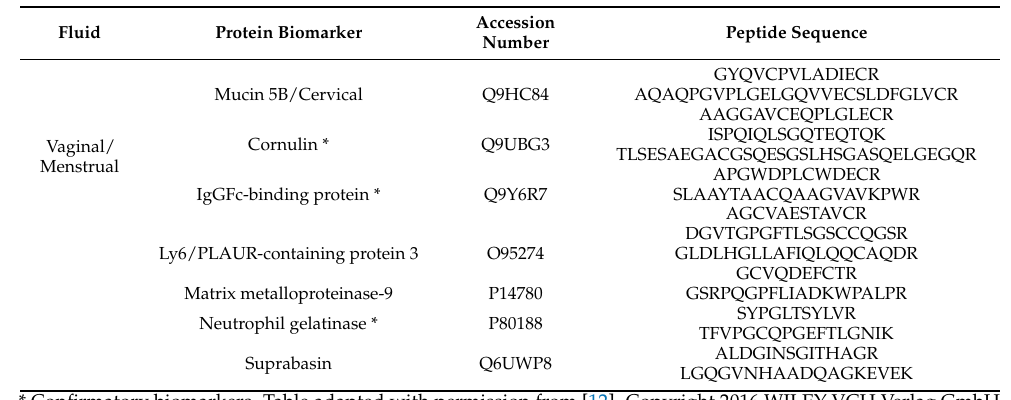
Table 3. Estimation of frequency at which target biomarkers may be detected in target and non-target body fluids.